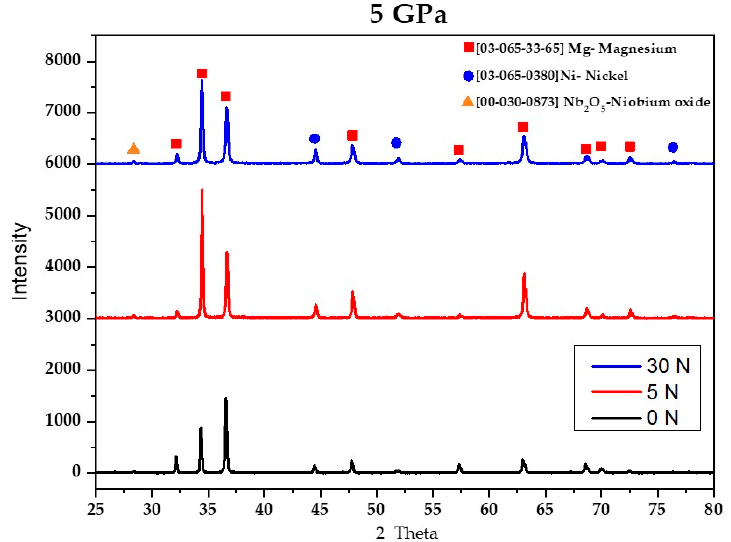
Figure 3. X-ray diffraction patterns for the precompacted and HPT consolidated powders (5 and 30 revolutions) under 5 GPa of pressure.